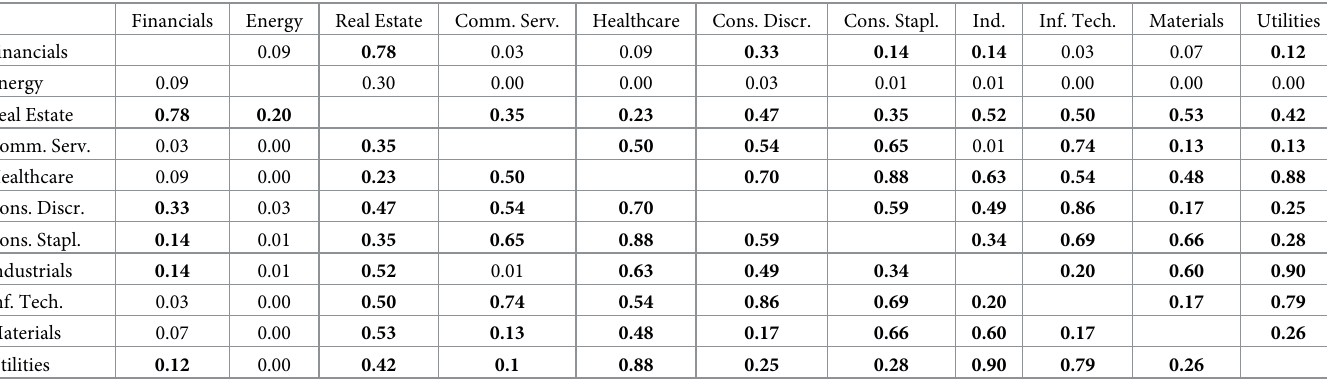
Table 15. All industries.